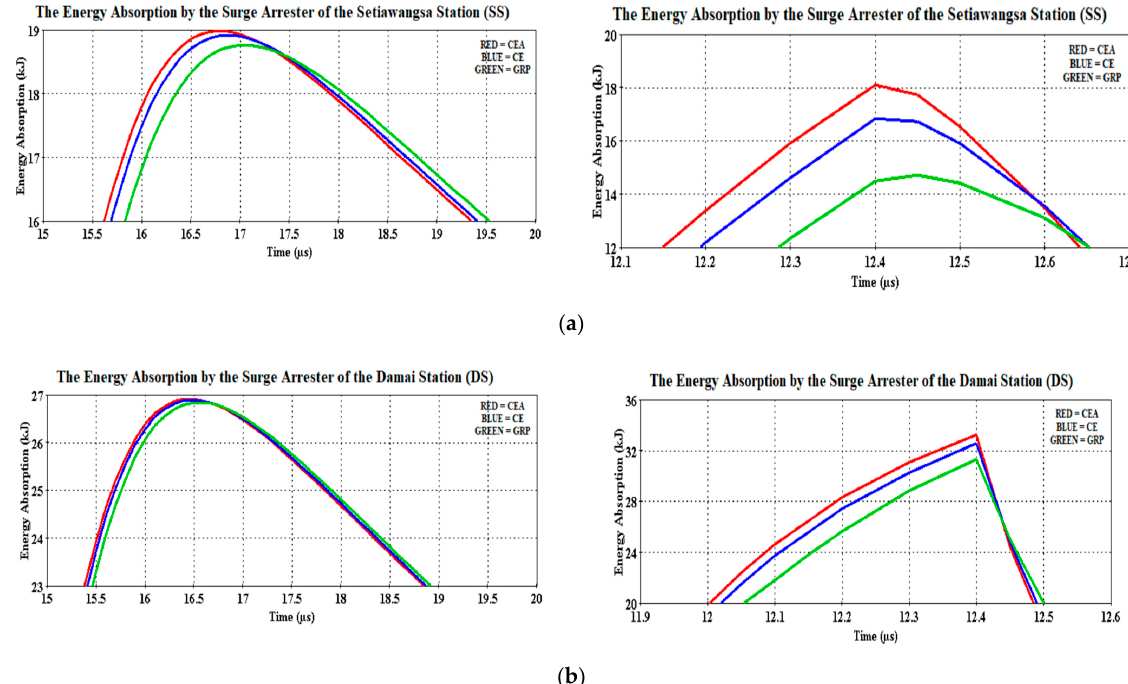
Figure 13. Magnified version of Figure 10. ( a ) Setiawangsa Station and ( b ) Damai Station surge arresters for both 30 kA ( left ) and 90 kA ( right